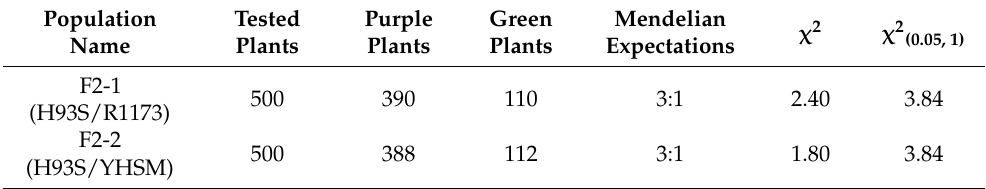
Table 1. Genetic analysis of the purple leaf sheath plants in two F2 segregating populations.